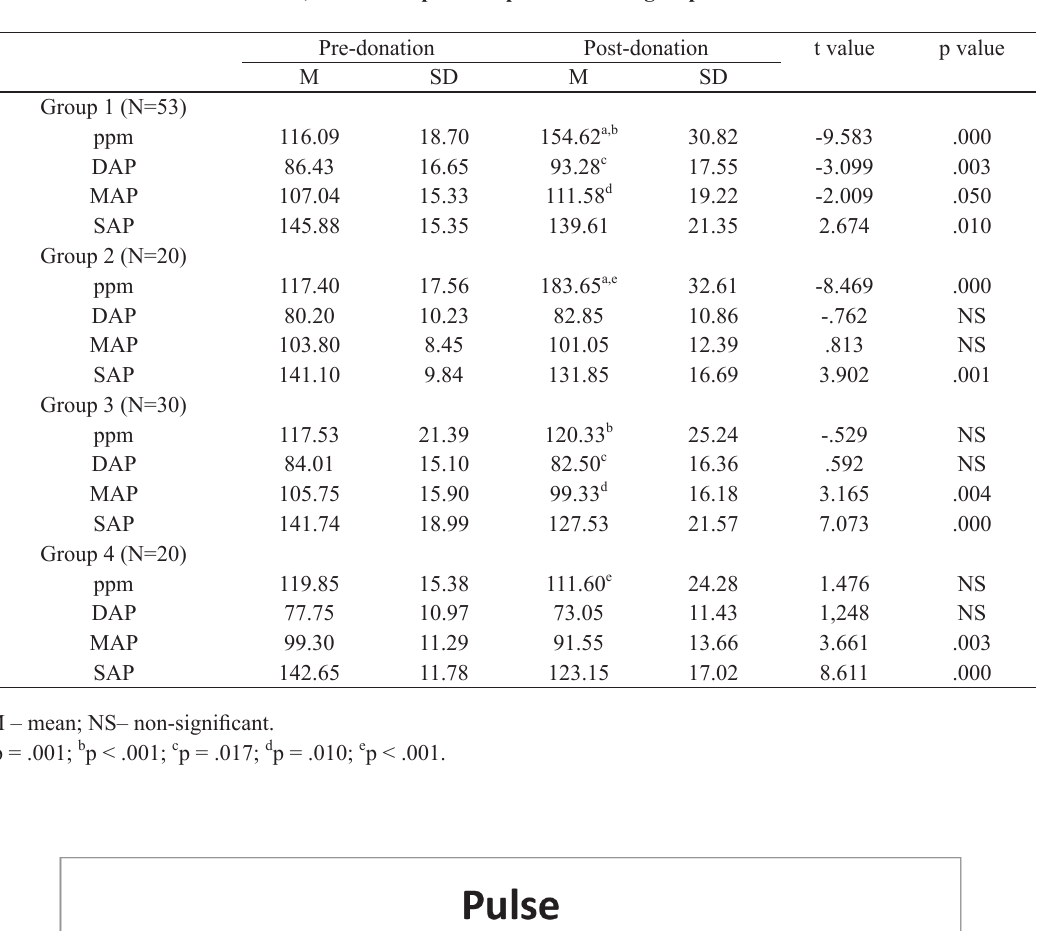
Pre- and post-donation pulse rates, SAP, MAP and DAP. Paired sample Student’s t-test and one-way ANOVA were used to compare differences between pulse rate, SAP, MAP and DAP before and after blood collections, and to compare the post-donation group differences.